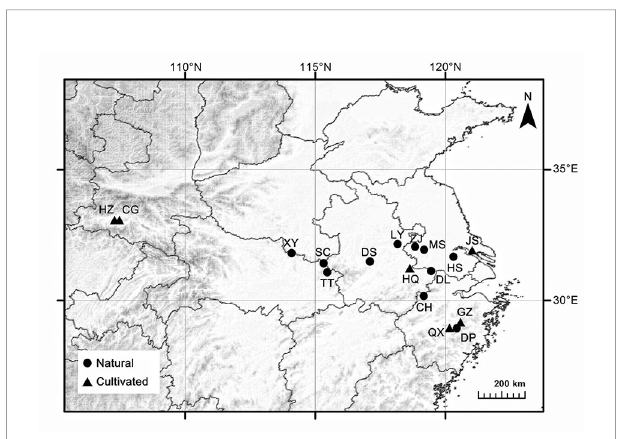
FIGURE 1 | Sampling locations of Corydalis yanhusuo populations. The circle represents natural populations and the triangle refers to cultivated